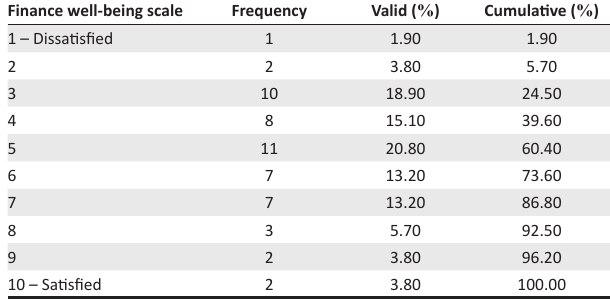
TABLE 2: How satisfied are you with your present financial